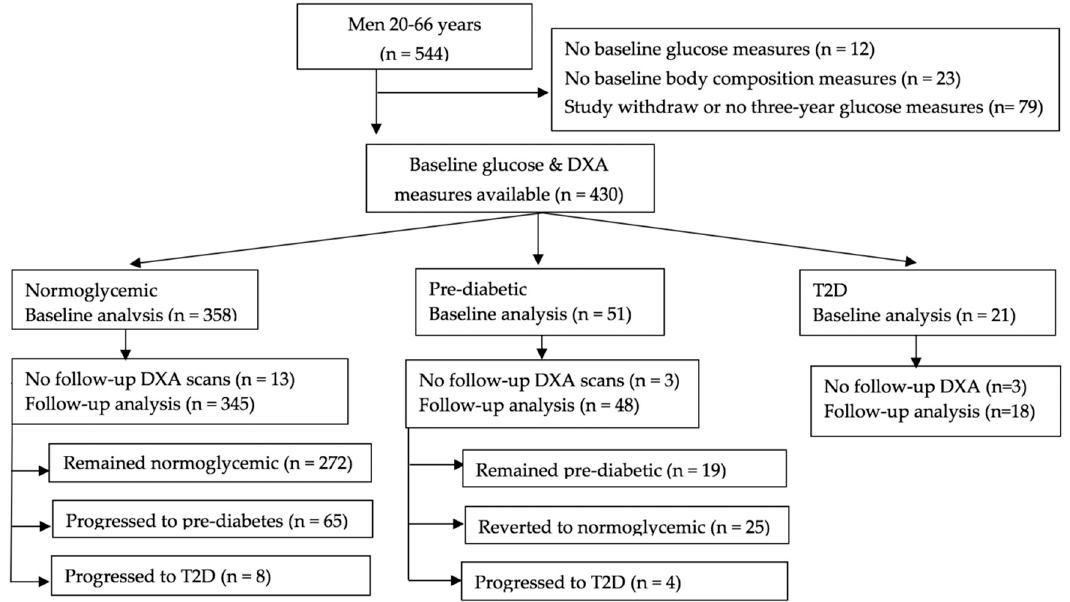
Figure 1. Flowchart of participants. Abbreviations: DXA, dual-energy X-ray absorptiometry; T2D, type 2 diabetic. Individuals who were unable to be categorized into glycemic groups were excluded.